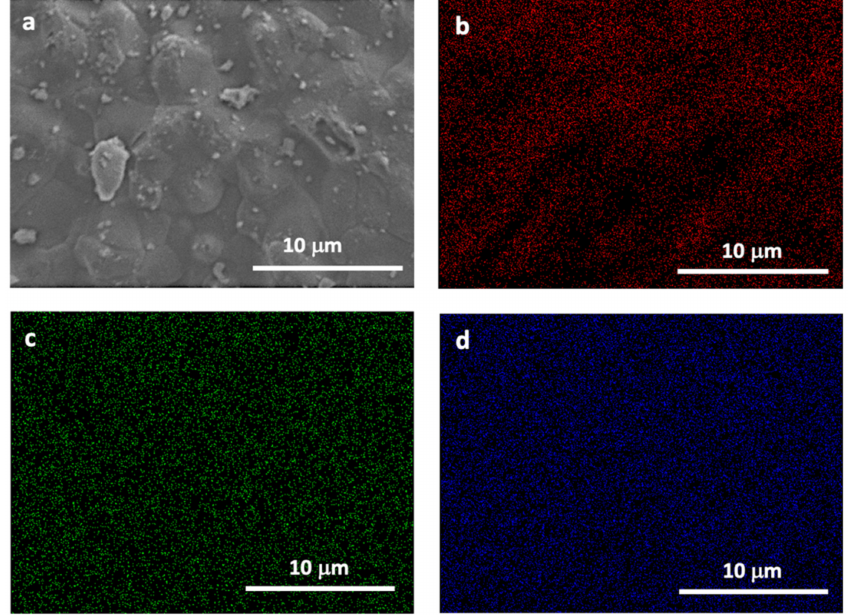
Figure 3. ( a ) SEM image and EDS mapping showing the ( b ) oxygen, ( c ) calcium, and ( d ) phosphor distribution of the BCP